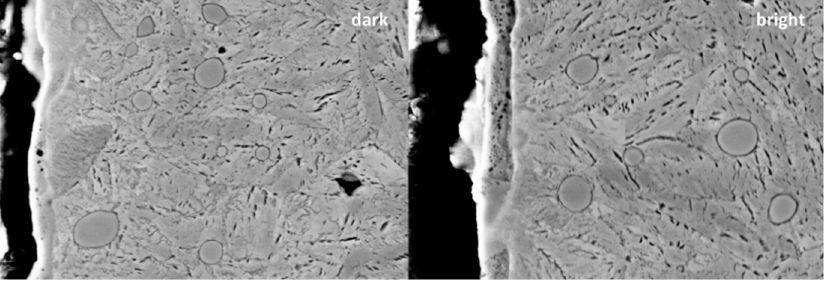
Figure 6. Bearing corrugated damage area subsurface.